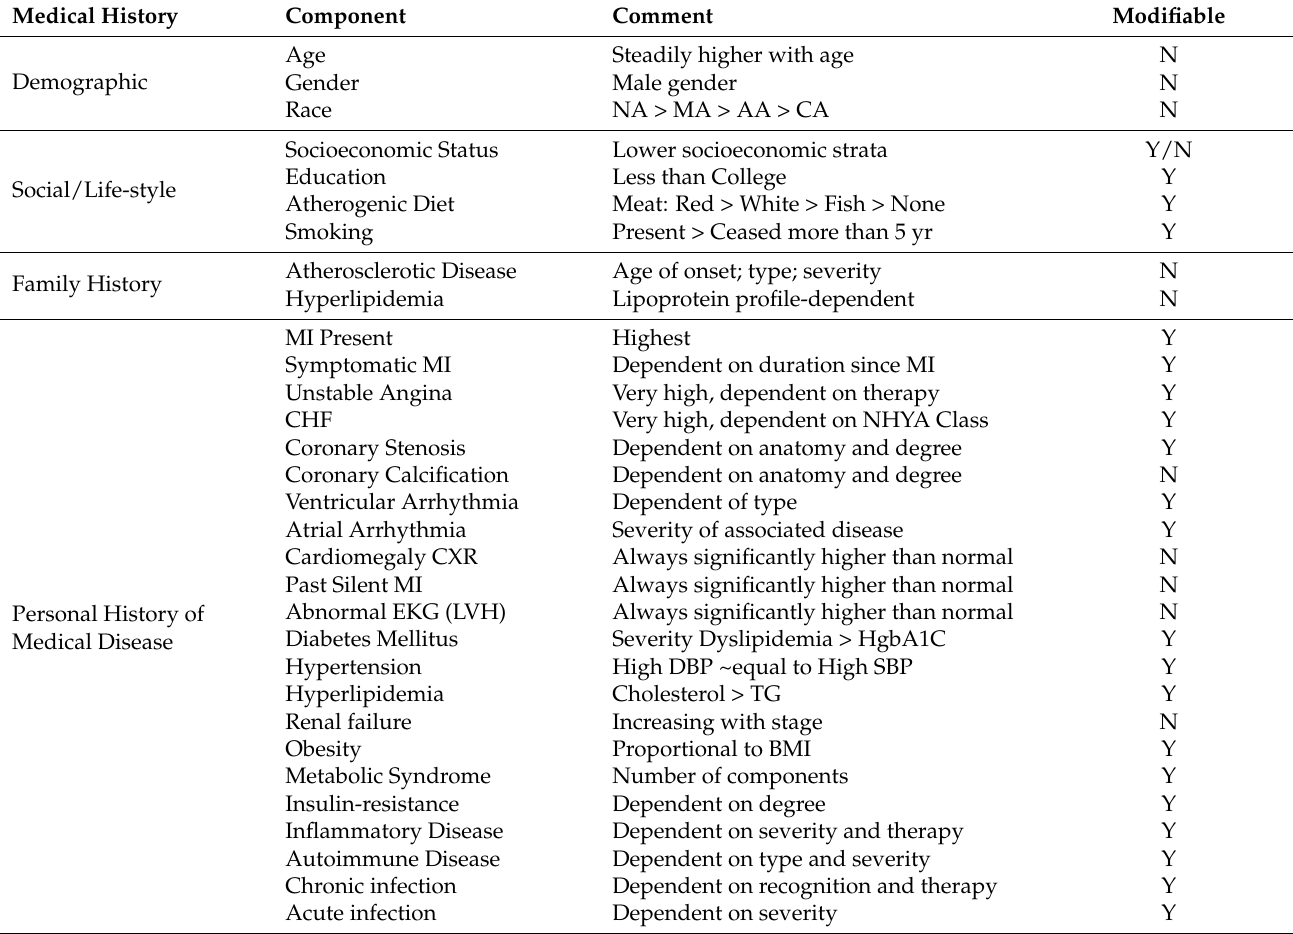
Table 2. Cardiovascular Risk Determination by Medical History (CVD